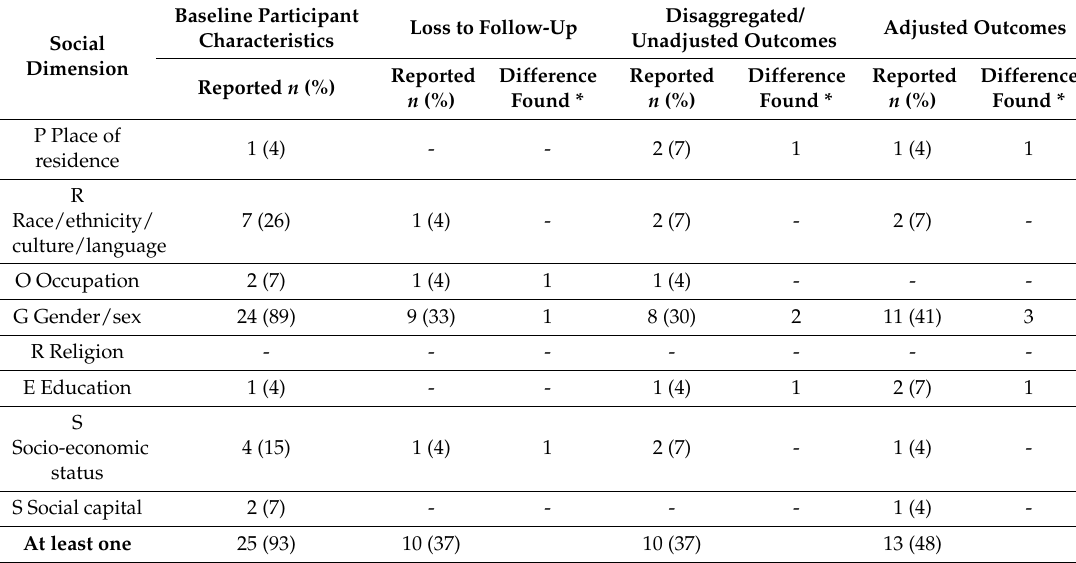
Table 3. Frequency of studies providing data on PROGRESS